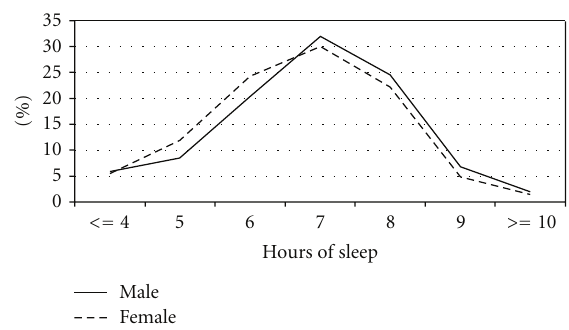
Figure 1: Distribution of sleep duration on an average school night, by sex—US high school